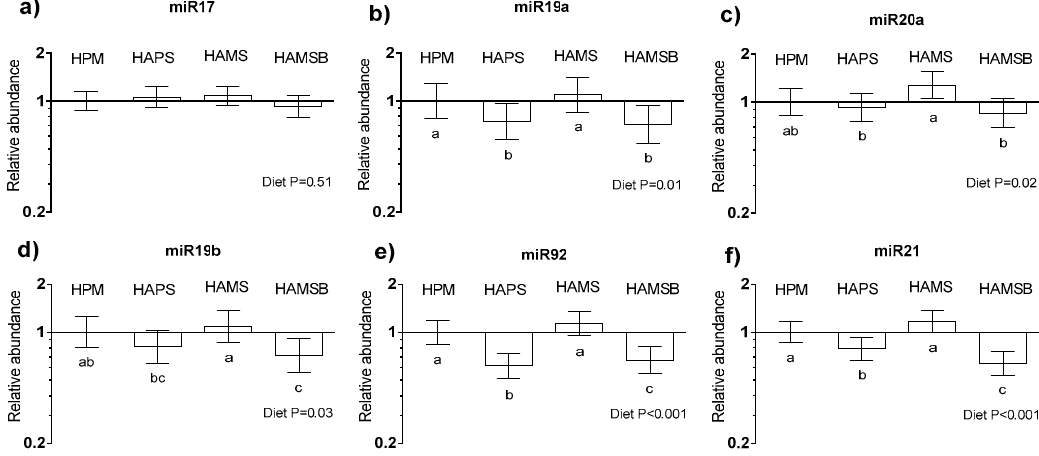
Figure 5. Relative abundance of miRNA’s in mucosal scrapings of the distal colon of rats fed the HPM, HAPS, HAMS, or the HAMSB diet ( n = 10 / group). ( a ) miR17, ( b ) miR19a, ( c ) miR20a, ( d ) miR19b, ( e ) miR92a, and ( f ) miR21. Data are presented as the means ± 95% confidence intervals relative to the abundance in the HPM-fed rats ( = 1) and are normalized against the beta-actin as the reference gene. Note that the scale on the Y-axis is logarithmic and that the units are arbitrary. Statistically significant ( p < 0.05) effects between diets are indicated with different letters (a, b, c).